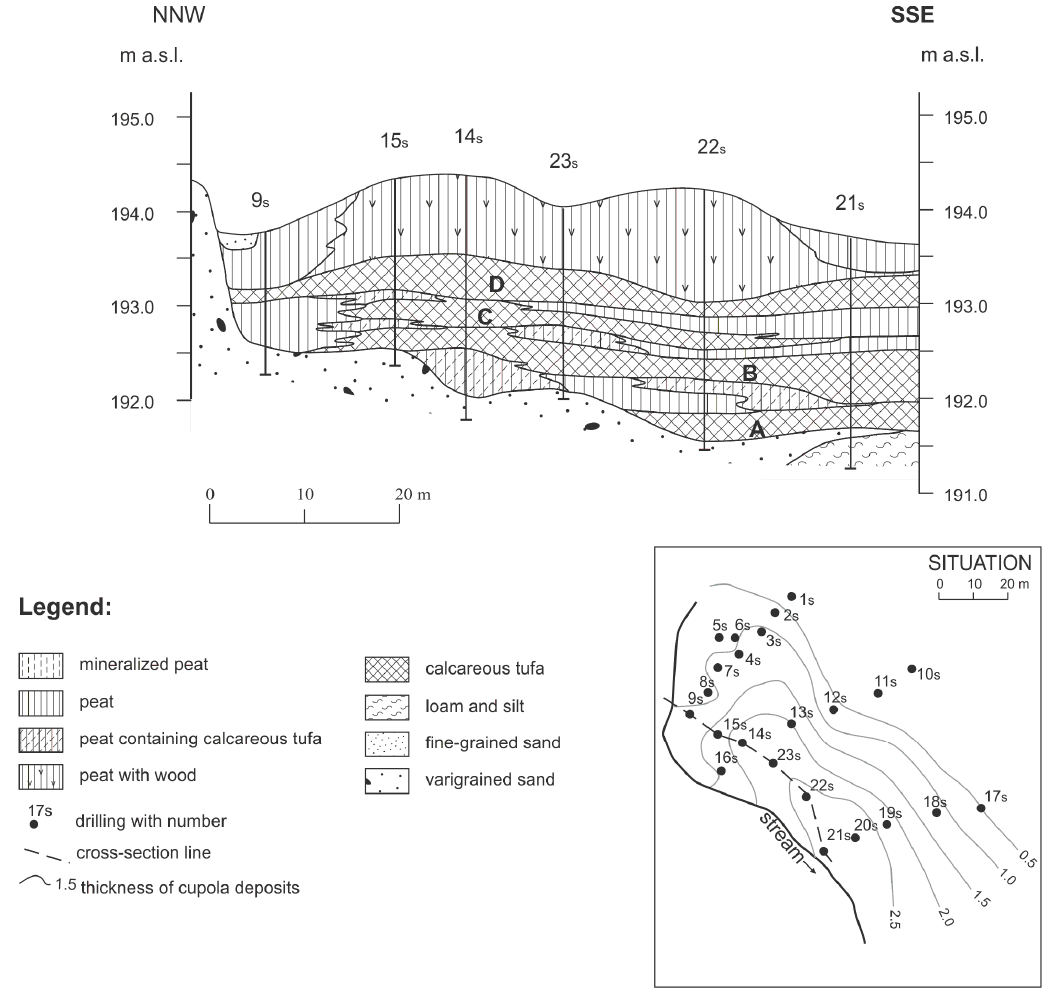
Figure 2. Schematic cross-section through the deposits of the spring mire cupola in Wardzy ń